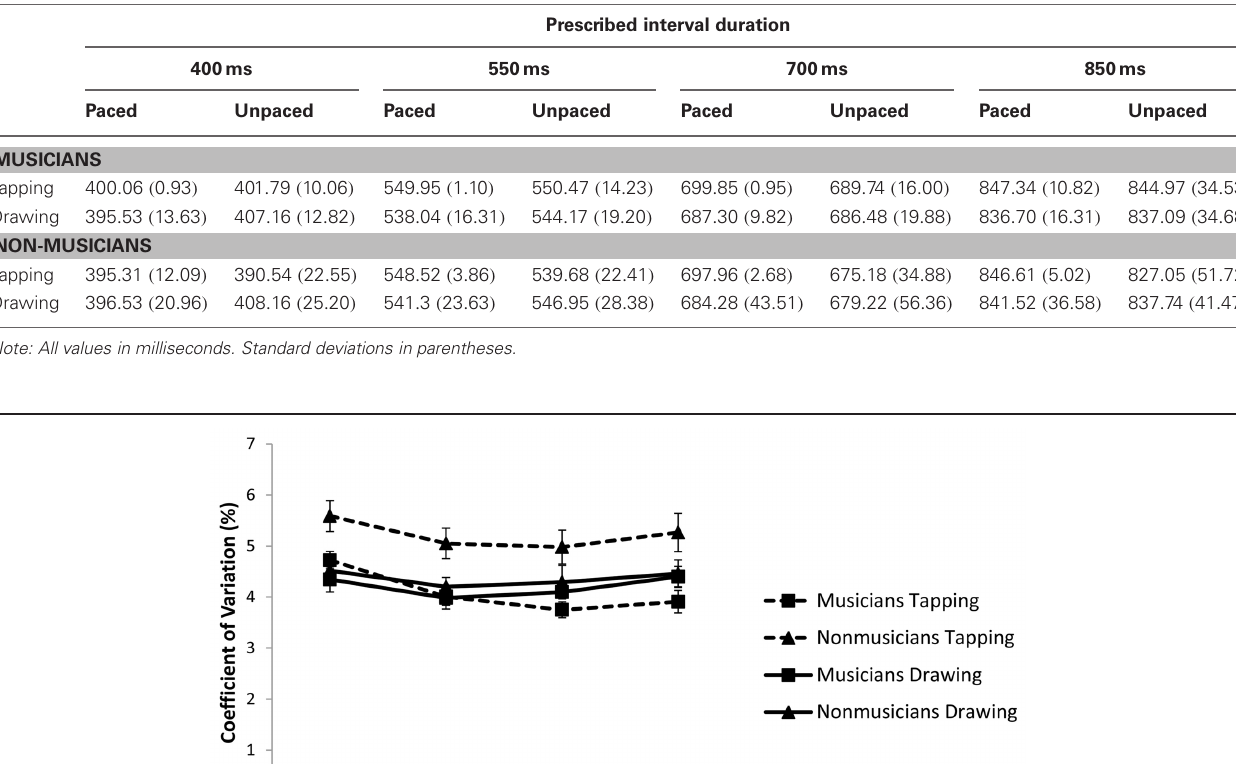
Table 1 | Mean inter-response intervals of the Paced and Unpaced phases.